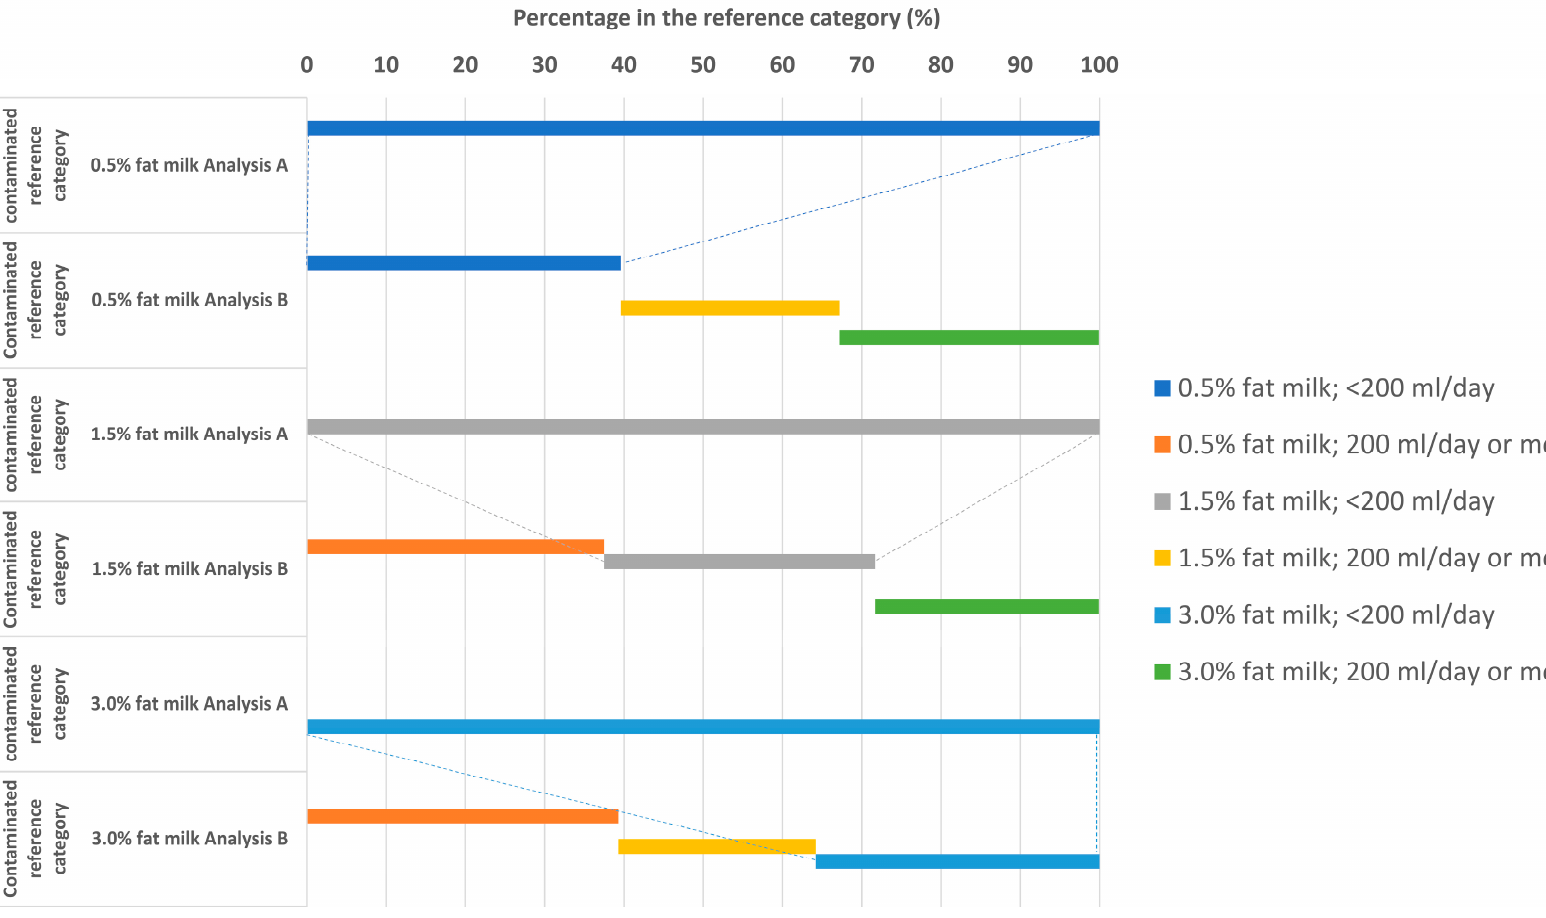
Figure 1. Proportion of different types of milk consumption by % fat in the reference category of analysis A (non-contaminated category) and analysis B (contaminated category). The dotted lines display that those in reference group of Analysis A are only a minority part of the reference group of Analysis B .